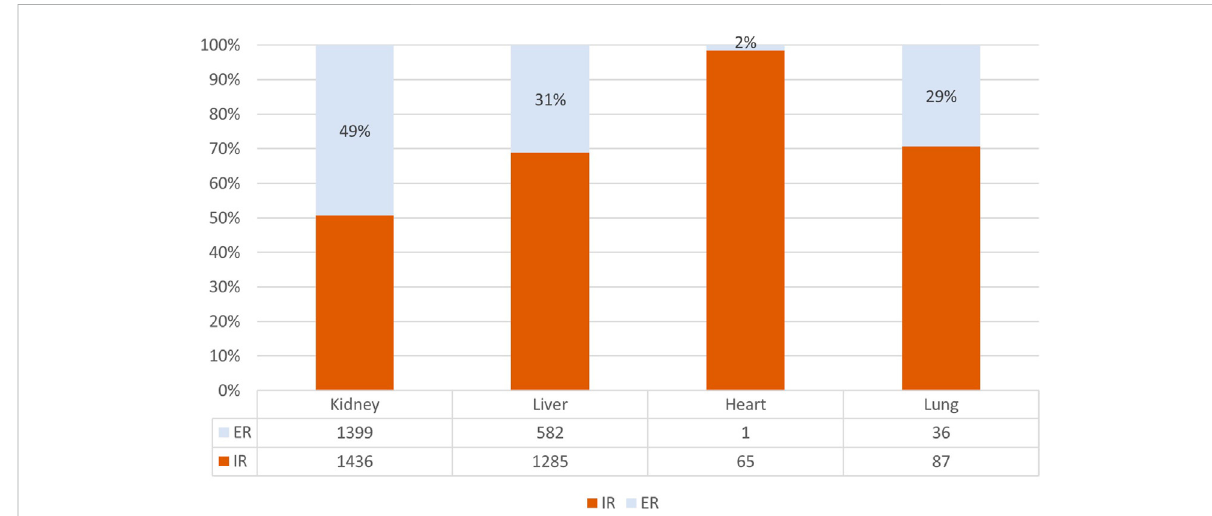
FIGURE 6 Percentage of immediate (IR) or extended release (ER) use among tacrolimus users.